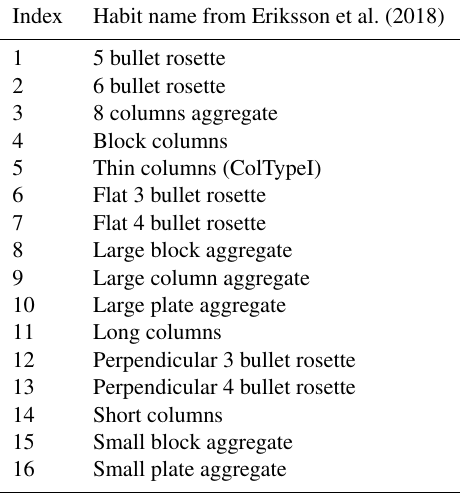
Table 1. Crystal habits used from Eriksson et al. (2018) database and their corresponding index in Fig.